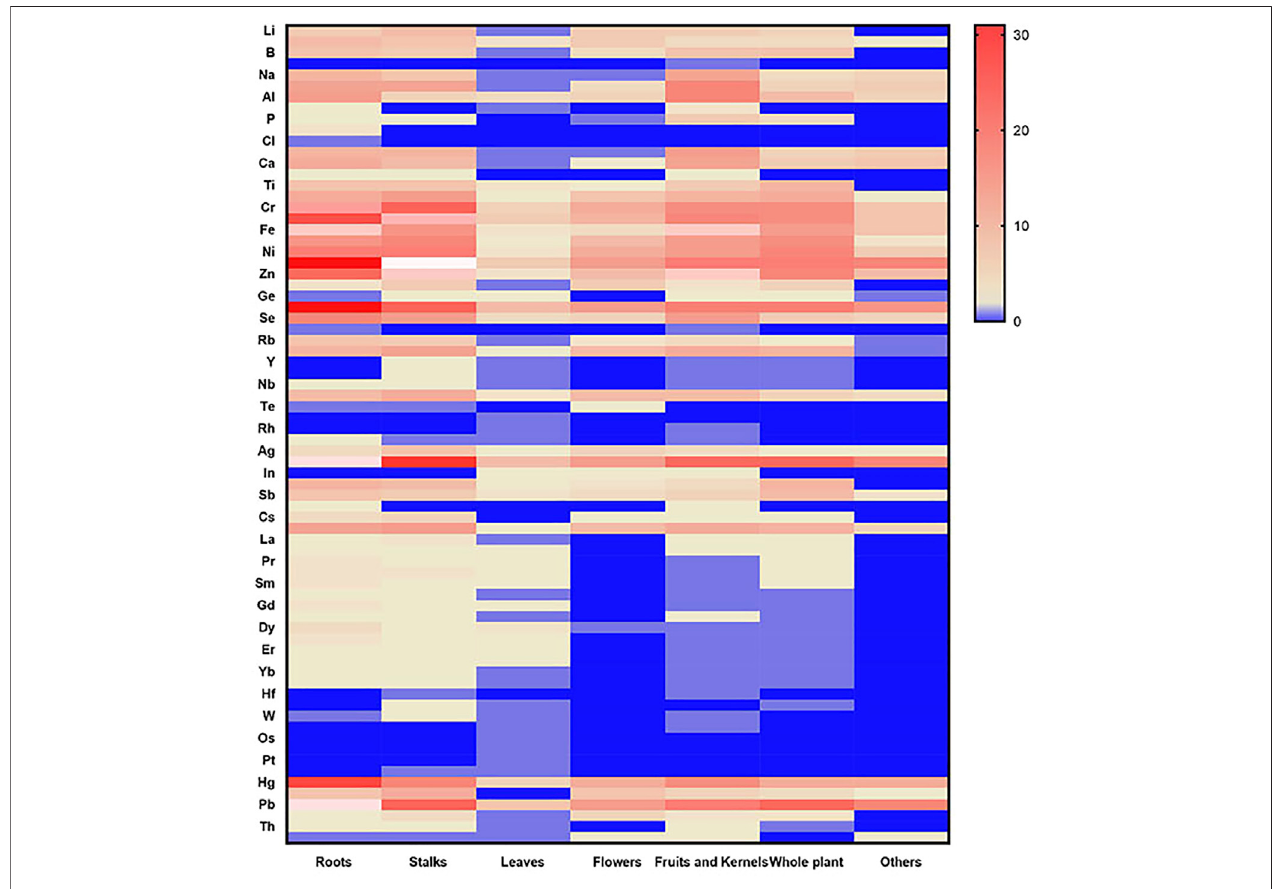
FIGURE 2 | Heat map of heavy metal elements measured by ICP-MS of medicinal materials derived from plants in different medicinal parts.